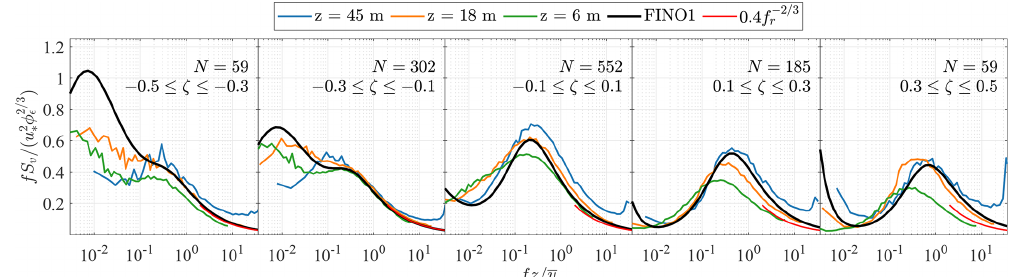
Figure 9. Normalised spectra of the cross-wind component at 45, 18, and 6ma.m.s.l. for various stability conditions. The red curve is derived from Eq. (6), and N denotes the number of samples considered for ensemble averaging.